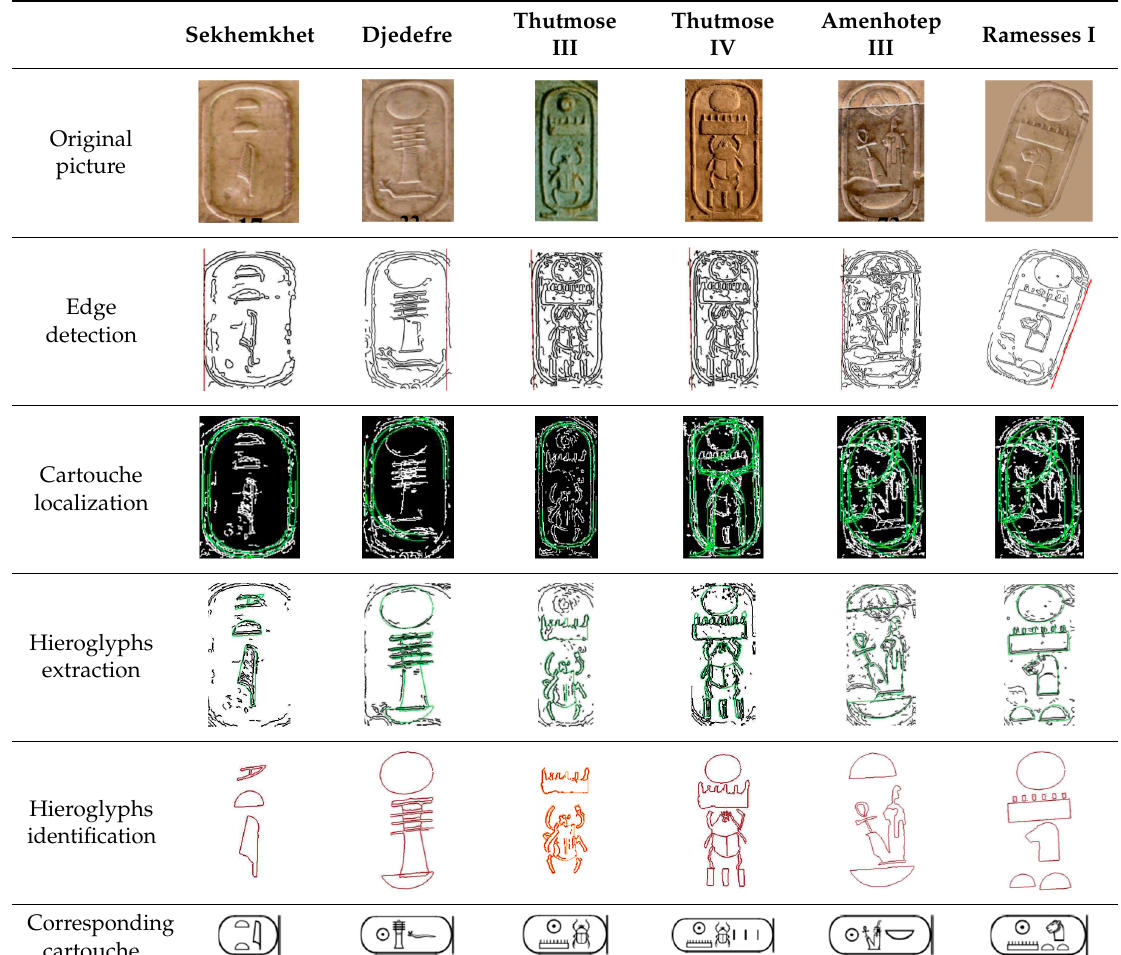
Table 2. List of selected cartouches for visualization purposes.